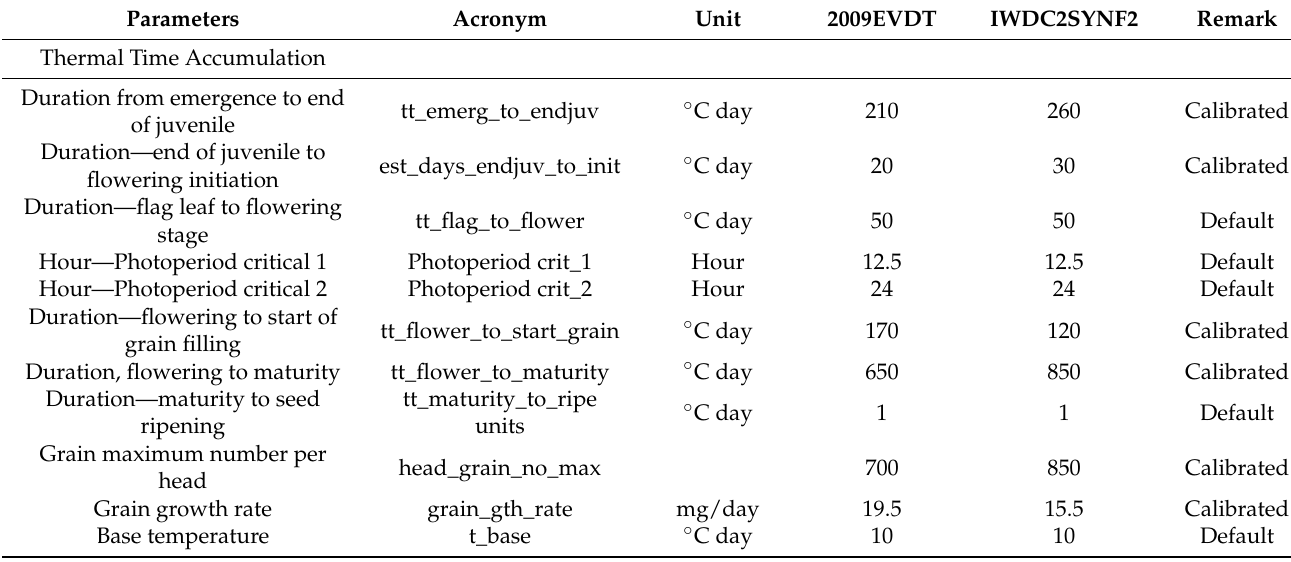
Table 2. Calibrated cultivar-specific parameters for 2009EVDT and IWDC2SYNF2 maize varieties.